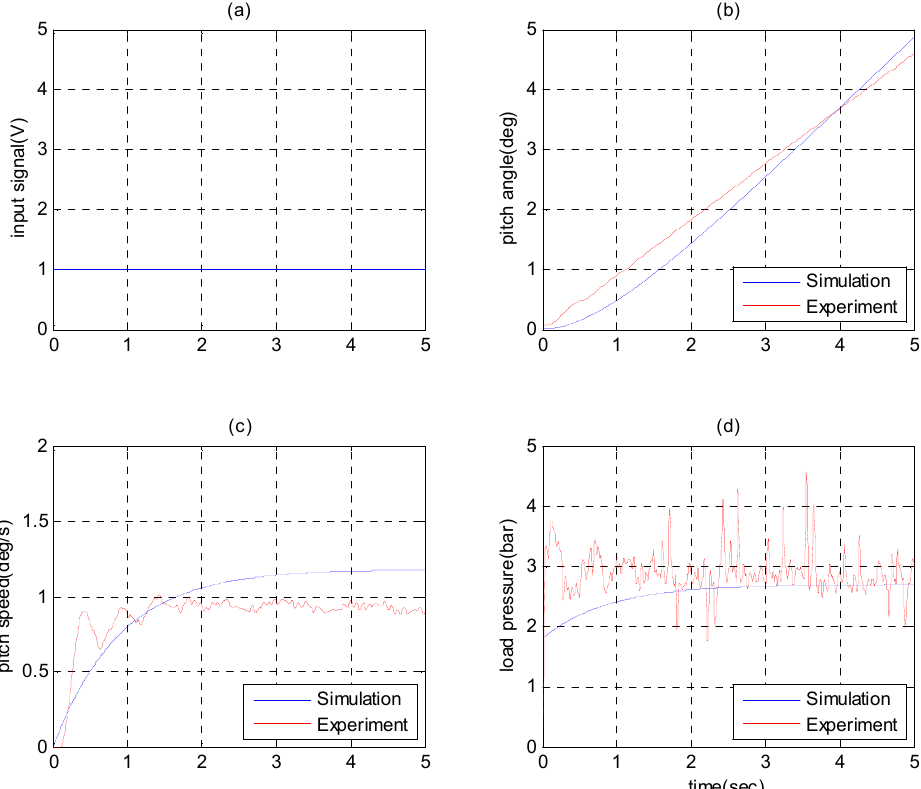
Figure 8. Model verification with step input 1 V: ( a ) Input signal; ( b ) Comparison of pitch angle; ( c ) Comparison of pitch speed; ( d ) Comparison of load pressure.